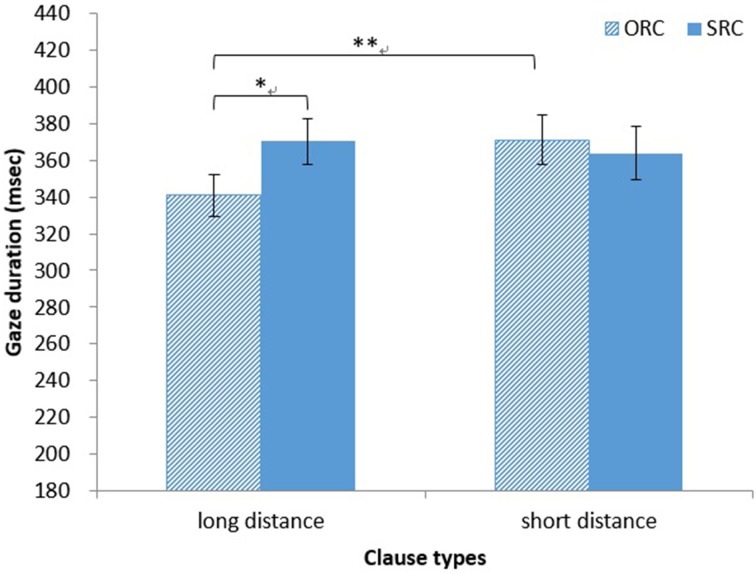
Japanese group: gaze duration for HNs in RCs. *p < 0.05, **p < 0.01.